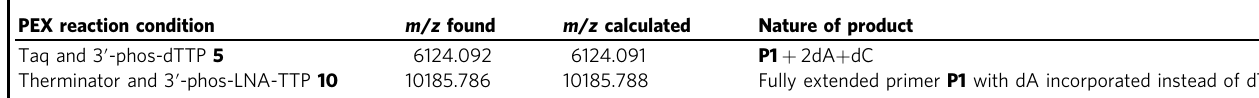
Table 1 Summary of LCMS analysis of PEX reaction products. PEX reaction